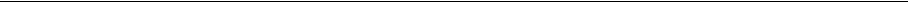
Fig. 2 VZV transcriptome pro fi le during lytic and latent infection. Strand-speci fi c mRNA-seq of lytically VZV-infected ARPE-19 cells and seven latently VZV-infected human trigeminal ganglia (TG) (Supplementary Table 1). a Circos plots of the VZV genome [purple band; sense and antisense open reading frames (ORFs) indicated as blue and red blocks, respectively], with internal tracks revealing the lytic (left) and latent (right) transcriptomes using unenriched (grey track, left panel) and VZV-enriched (black tracks, left and right panels) libraries. Right panel: latent VZV transcriptome of seven TG, with each track depicting a single specimen. Peaks facing outward from the centre indicate reads mapping to the sense strand, while peaks facing inward originate from the antisense strand. The y axis is scaled to maximum read depth per library in all cases. b Linear representation of the varicella latency- associated transcript (VLT) genomic region (black lines in a ), with blue and yellow tracks depicting VZV-enriched mRNA-Seq reads originating from the sense and antisense strands, respectively. Unenriched mRNA-Seq tracks for ARPE-19 cells, and TGs 1 and 2, are superimposed and shown in light blue (sense) or yellow (antisense), with overlapping regions in medium-blue and orange, respectively. No VZV-mapping reads were obtained from unenriched sequence data sets generated from TGs 1 and 2. VZV genome coordinates are shown the VZV reference strain Dumas (NC_001348.1); blue and red arrows indicate previously described VZV ORFs, and light blue boxes indicate the fi ve VLT exons. Paired-end read data sets were generated with read lengths of 2 × 34 bp (ARPE-19) or 2 × 76 bp (TG1 and TG2) or 2 × 151 bp (TG3 –